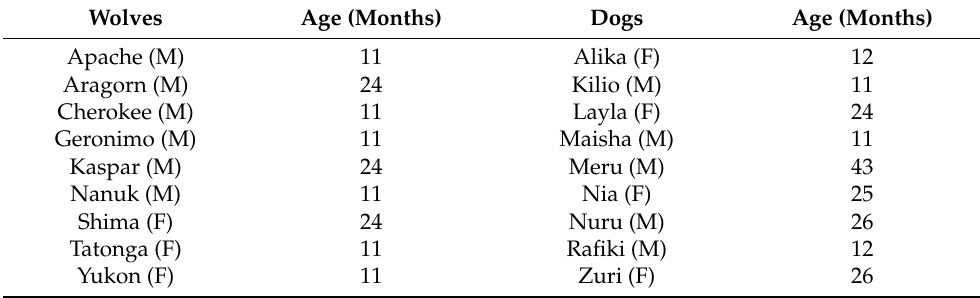
Table 1. Names, sexes *, and ages (in months, at the moment of data collection) of the dogs and wolves that participated of Positive Reinforcement Training sessions in this study. Wolves Age (Months) Dogs Age (Months) Apache (M) 11 Alika (F) 12 Aragorn (M) 24 Kilio (M) Cherokee (M) Layla (F) Geronimo (M) Kaspar (M) Nanuk (M) Shima (F) Tatonga (F) Yukon (F) Zuri